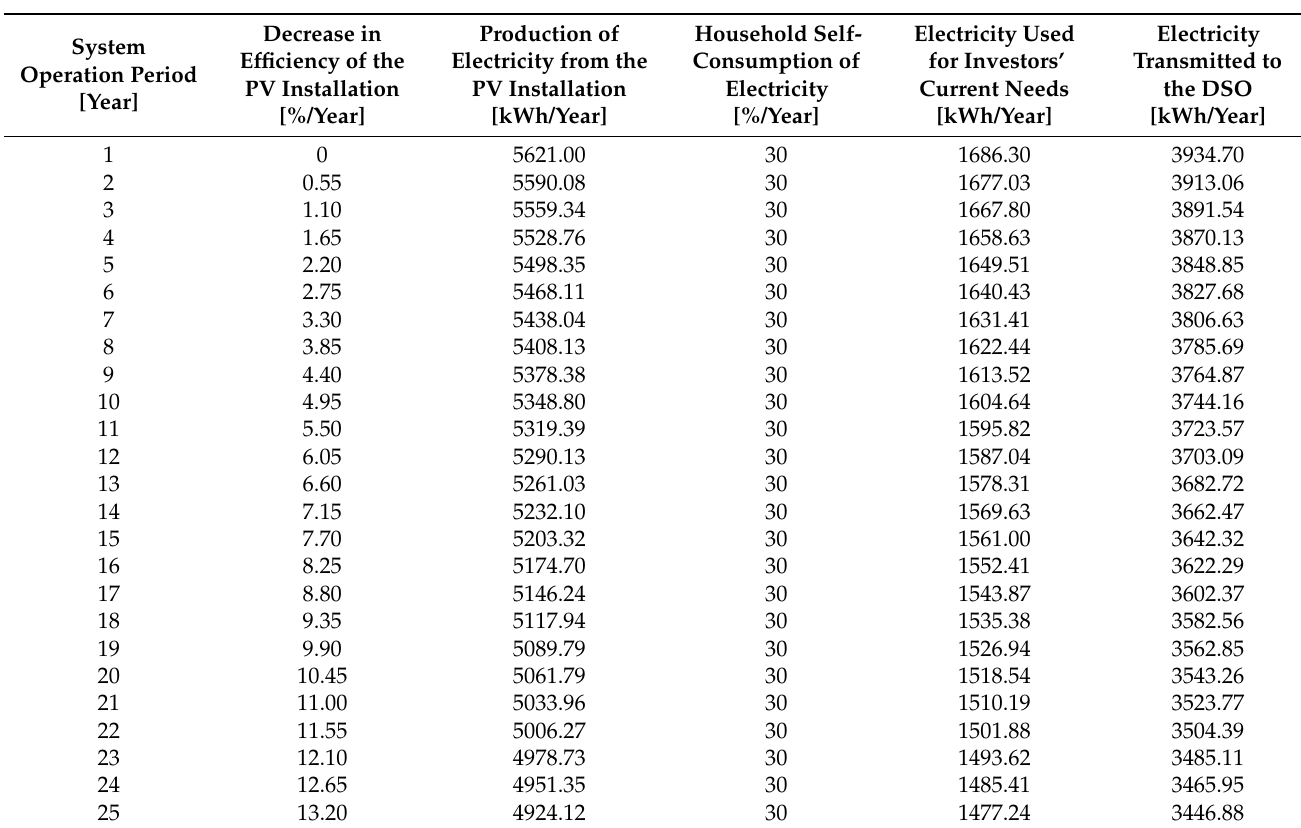
Table 2. Calculation results of electricity production from the designed photovoltaic